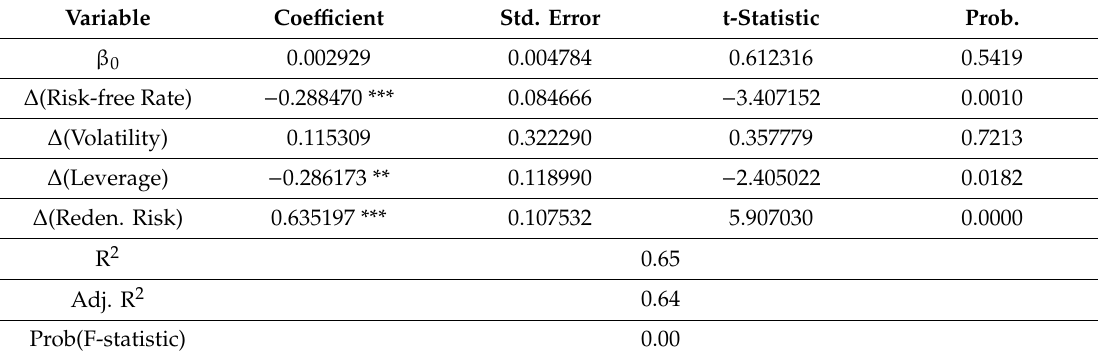
Table 5. OLS estimates: period March 2018–September 2018 (96